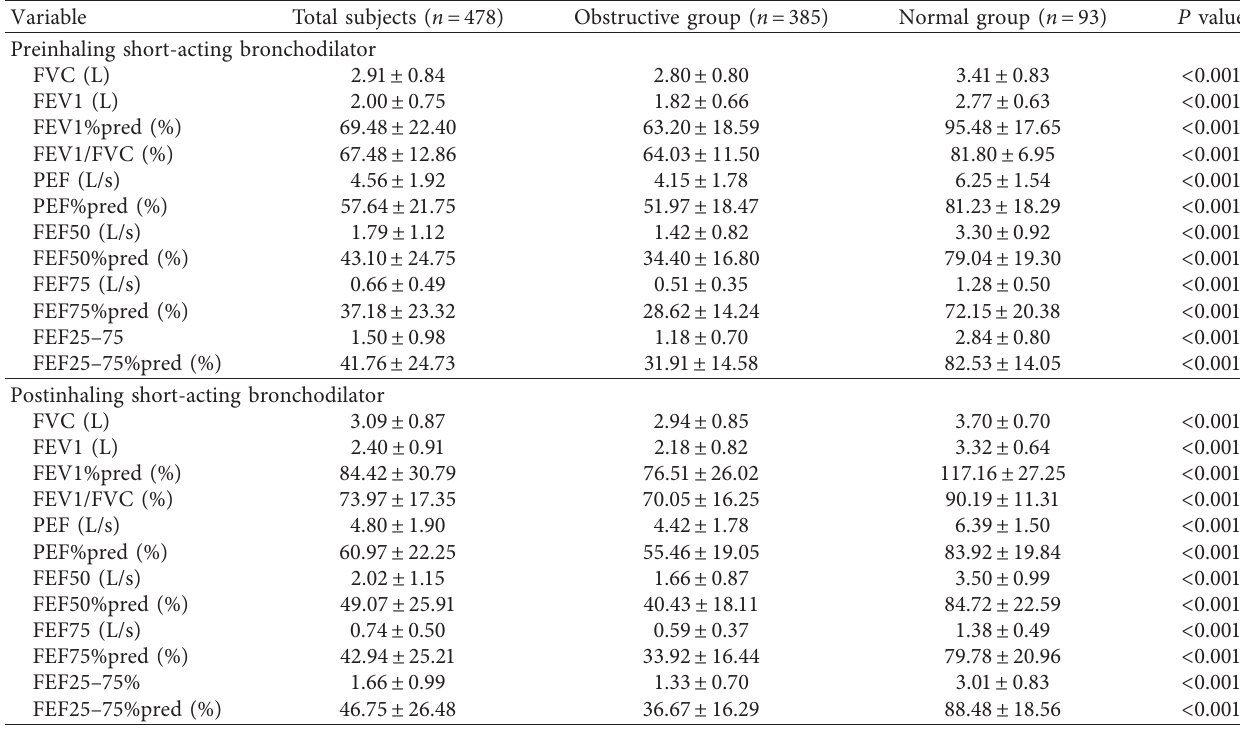
Table 2: Baseline lung function of subjects.